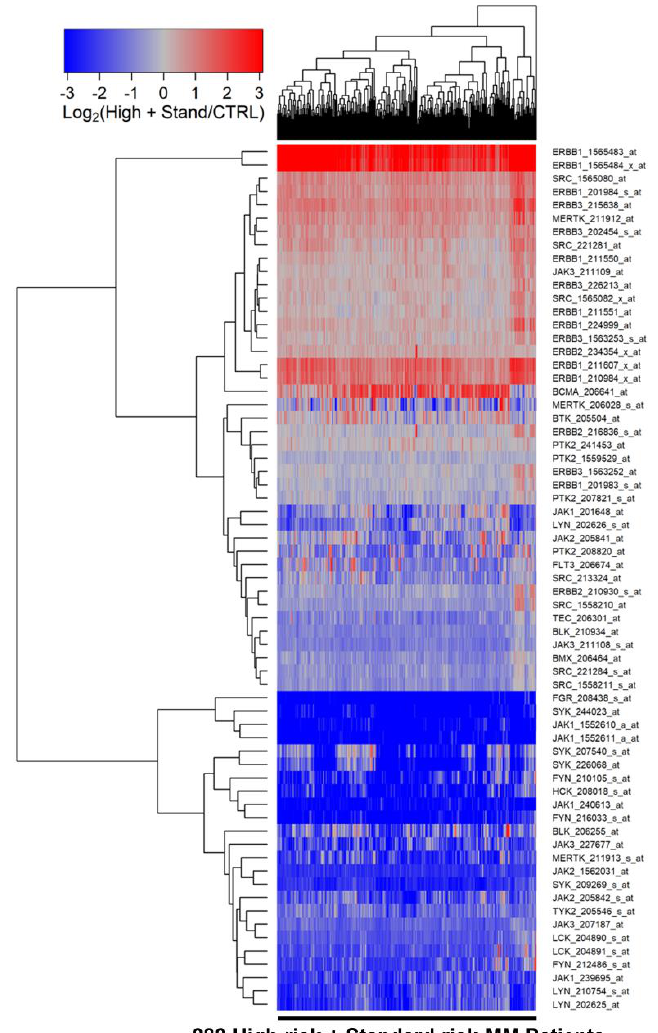
Figure 1. Gene Expression Levels for Tyrosine Kinases in Malignant Plasma Cells from MM Patients vs. Normal Plasma Cells from Healthy Subjects. We examined the gene expression data in the archived MM dataset GSE19784 and the control plasma cell dataset from GSE171739. The cluster figure displays the expression levels in malignant plasma cells from MM patients (high-risk and standard-risk MM patients combined) mean centered to the expression levels in normal plasma cells for log 2 -transformed fold-change values (blue represents underexpression and red color represents overexpression in MM cells). The expression levels of co-regulated probesets for both probesets (rows) and patients (columns) are organized in the depicted dendrograms. The comparison of the log 2 -transformed RMA values for normal plasma cells from 7 control samples with RMA values for malignant plasma cells from 282 MM patients showed that 46 probesets were significantly dys- regulated of which 10 were upregulated in the malignant plasma cells from MM patients (FDR = 0.07). ERBB1_1565483_at was the most significantly upregulated probeset (Fold Change = 16.86; p -value < 10 − 8 ) followed by ERBB1_1565484_x_at (Fold Change = 9.91; p -value < 10 − 8 ) and ERBB1_211607_x_at (Fold Change = 2.54; p -value = 2.7 × 10 − 6 ) (Table S1). Five probesets for ERBB1 and 2 probesets for ERBB3 were significantly over expressed in MM cells. SRC (2 probesets), ERBB1, ERBB3 (2 probesets) and MERTK formed a cassette of upregulated probesets in these pooled MM patients. BCMA was co-regulated with 2 probesets for ERBB1.